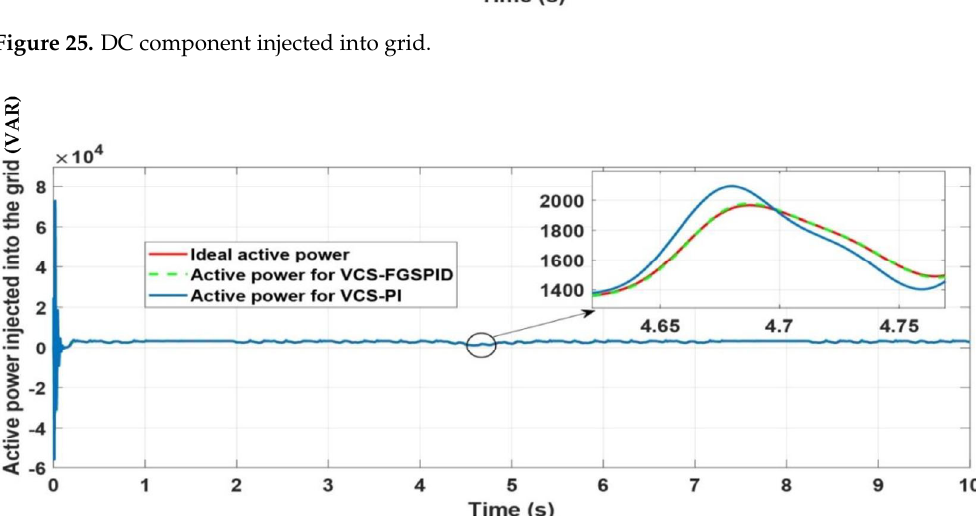
Figure 26. Active power injected into grid.